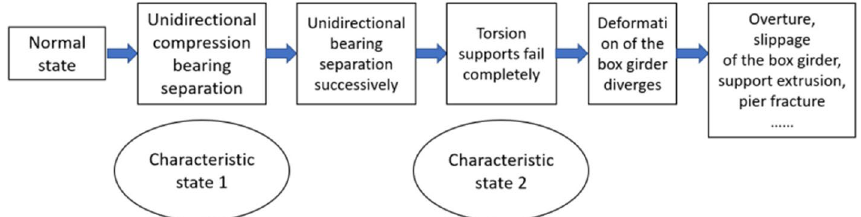
Fig. 16 Typical failure state of the box